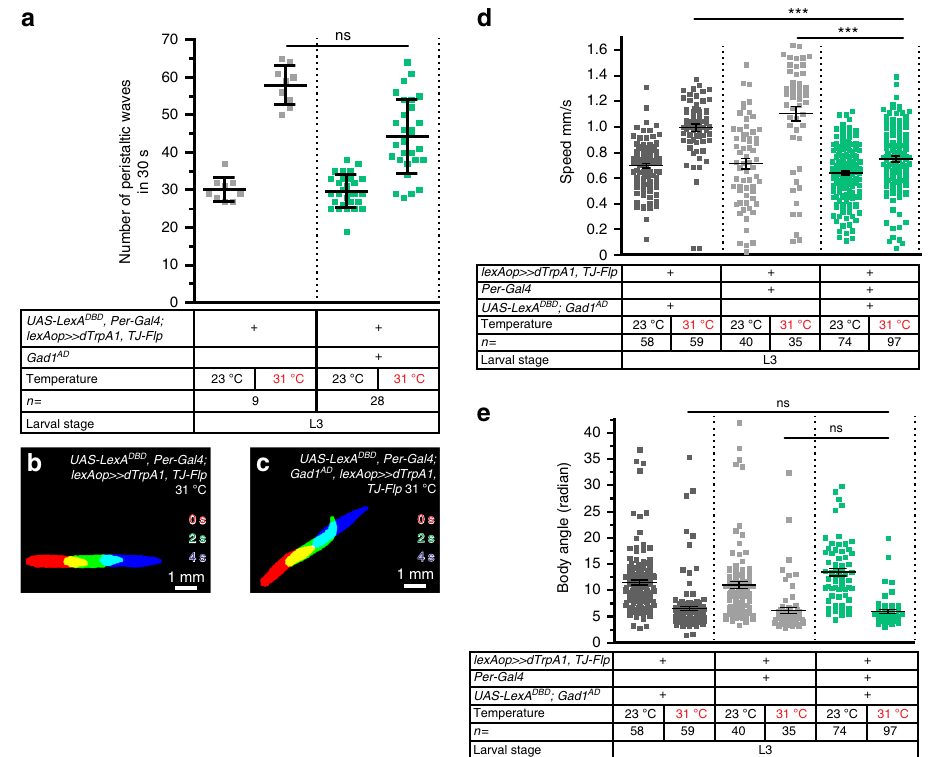
Fig. 8 Three TJ + / Per + GABAergic neurons per segment impact locomotor speed. a Number of peristaltic waves per 30 s at (23 °C) and (31 °C) temperatures done by larvae expressing TrpA1 in three TJ + / Per + GABAergic neurons per segment (green – blue dot plot) versus controls that do not express TrpA1 (gray dot plot). Activation of the TJ + / Per + GABAergic population (three cells per segments) leads to a decrease (albeit non-signi fi cant) in the number of peristaltic waves done by third instar larvae (second green – blue dot plot). Error bars indicate the mean ± SD and n the number of larvae tested. Statistical test: Kruskall – Wallis. ns = non-signi fi cant. b , c Superimposition of three consecutive time frames (0, 2, and 4 s) showing the postures of third instar control larvae ( b ) and upon activation of the TJ + / Per + GABAergic population ( c ). d Speed of larvae expressing TrpA1 in three TJ + / Per + GABAergic neurons (green – blue dot plot) versus their respective controls that do not express TrpA1 (gray dot plot). e Body angle (in radian) of larvae expressing TrpA1 in three TJ + / Per + GABAergic neurons (green – blue dot plot) versus their respective controls that do not express TrpA1. d , e Statistical analysis: Z -test. *** p ≤ 0.001. ** p ≤ 0.01. ns = non-signi fi